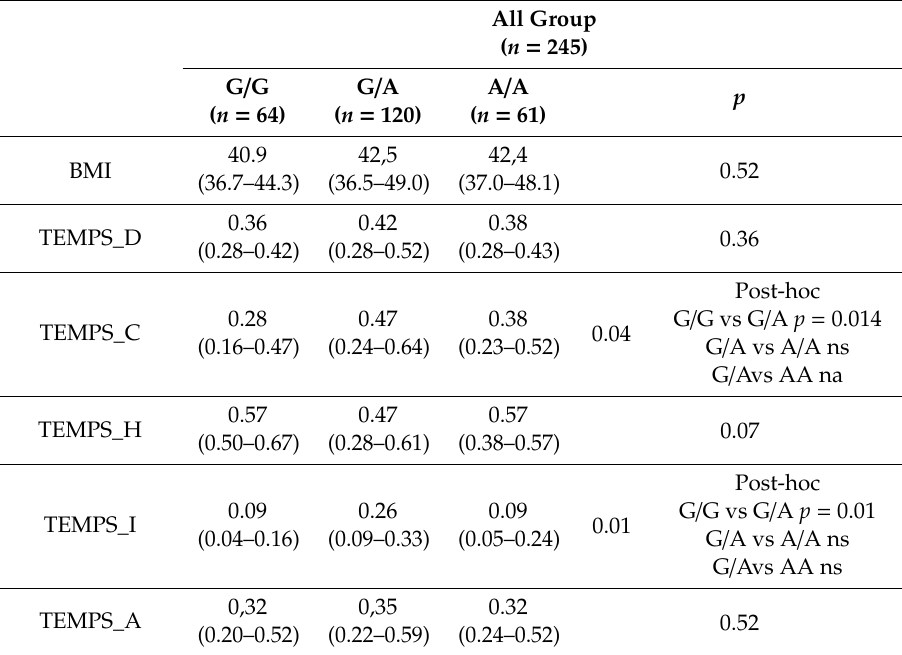
Table 3. COMT polymorphisms and TEMPS results in study group.